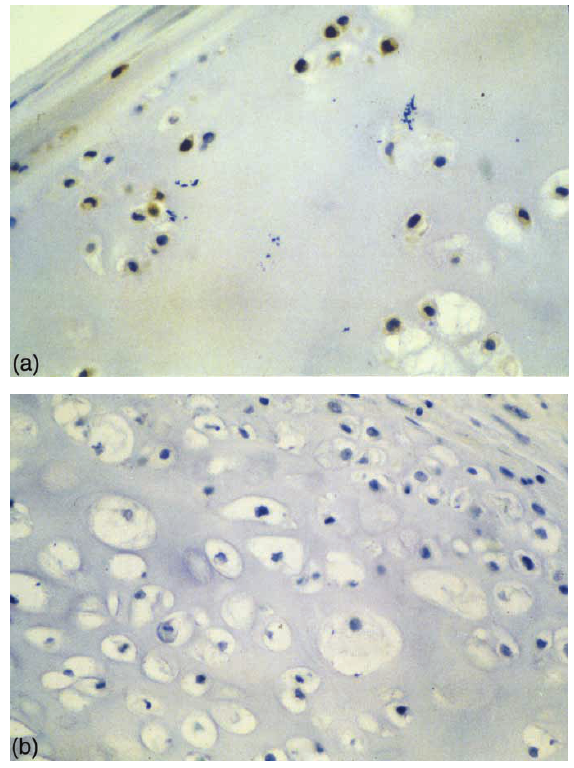
Fig. 3. Immunoperoxidase staining for Bcl-2 from our case. (a) Synovial chondromatosis (1992), showing cytoplasmic positivity for Bcl-2 in the chondrocytes. (b) Chondrosarcoma (1999), showing no staining for Bcl2 in the